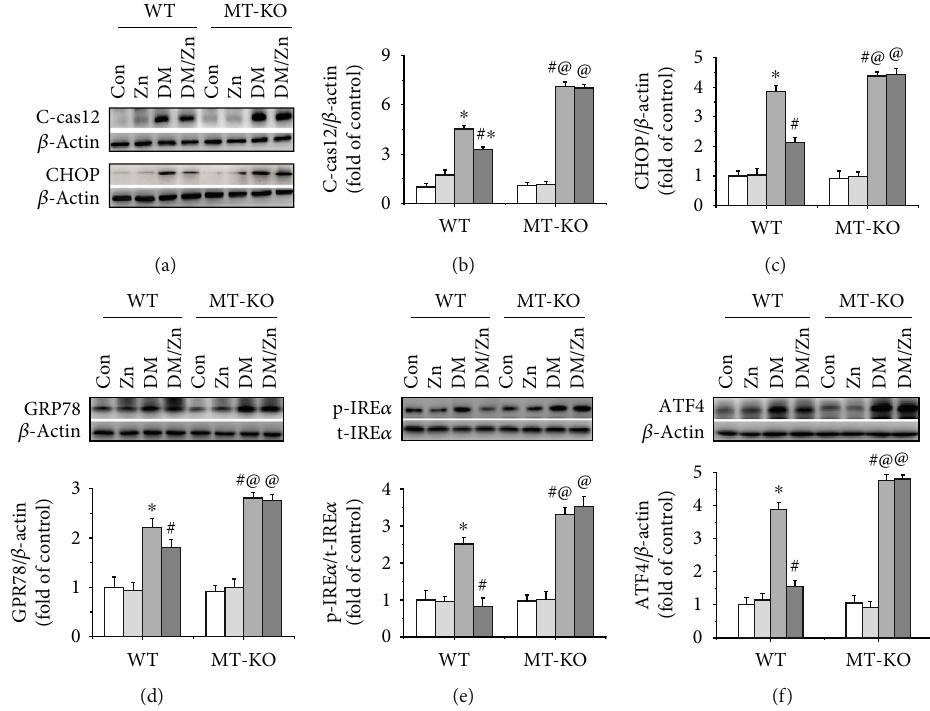
Figure 8: The role of endogenous MT in zinc supplementation-induced anti-ER stress in the liver of type 2 diabetic mice. Hepatic indexes of ER stress including cleaved-caspase12 (C-cas12) (a, b), CHOP (a, c), GRP78 (d), phosphorylated IRE- α (e), and ATF4 (f) were examined by western blot analysis. Data are presented as the mean ± standard deviation ( n = 8 /group). ∗ P < 0 : 05 vs. the control (Con) group in WT mice; # P < 0 : 05 vs. the type 2 diabetes (DM) group in WT mice; @ P < 0 : 05 vs. the control (Con) group in MT-KO